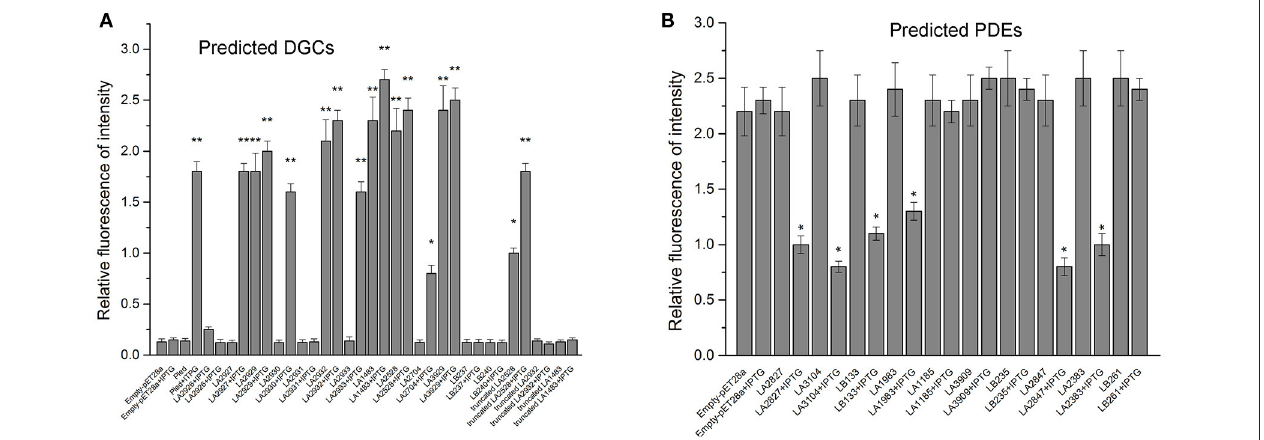
FIGURE 3 | Multiple DGCs (A) and PDEs (B) from L. interrogans affect c-di-GMP accumulation in heterologous hosts. The RFI was defined as the ratio between the fluorescence intensities of TurboRFP at 574nm and AmCyan at 489nm and shows a linear correlation with intracellular c-di-GMP levels. Fluorescence intensity of DGCs and PDEs report strains were detected by Spectramax M5. Report strains culture, induction, photography and measurement of RFI were carried out as described in material section. Empty-pET-28a and pET-28a-pleD were used as negative control and positive control, respectively. Error bars represent the mean ± SD of three independent replicates. P -values were calculated by the two-tailed Student’s t -test. * p < 0.05, ** p < 0.01.